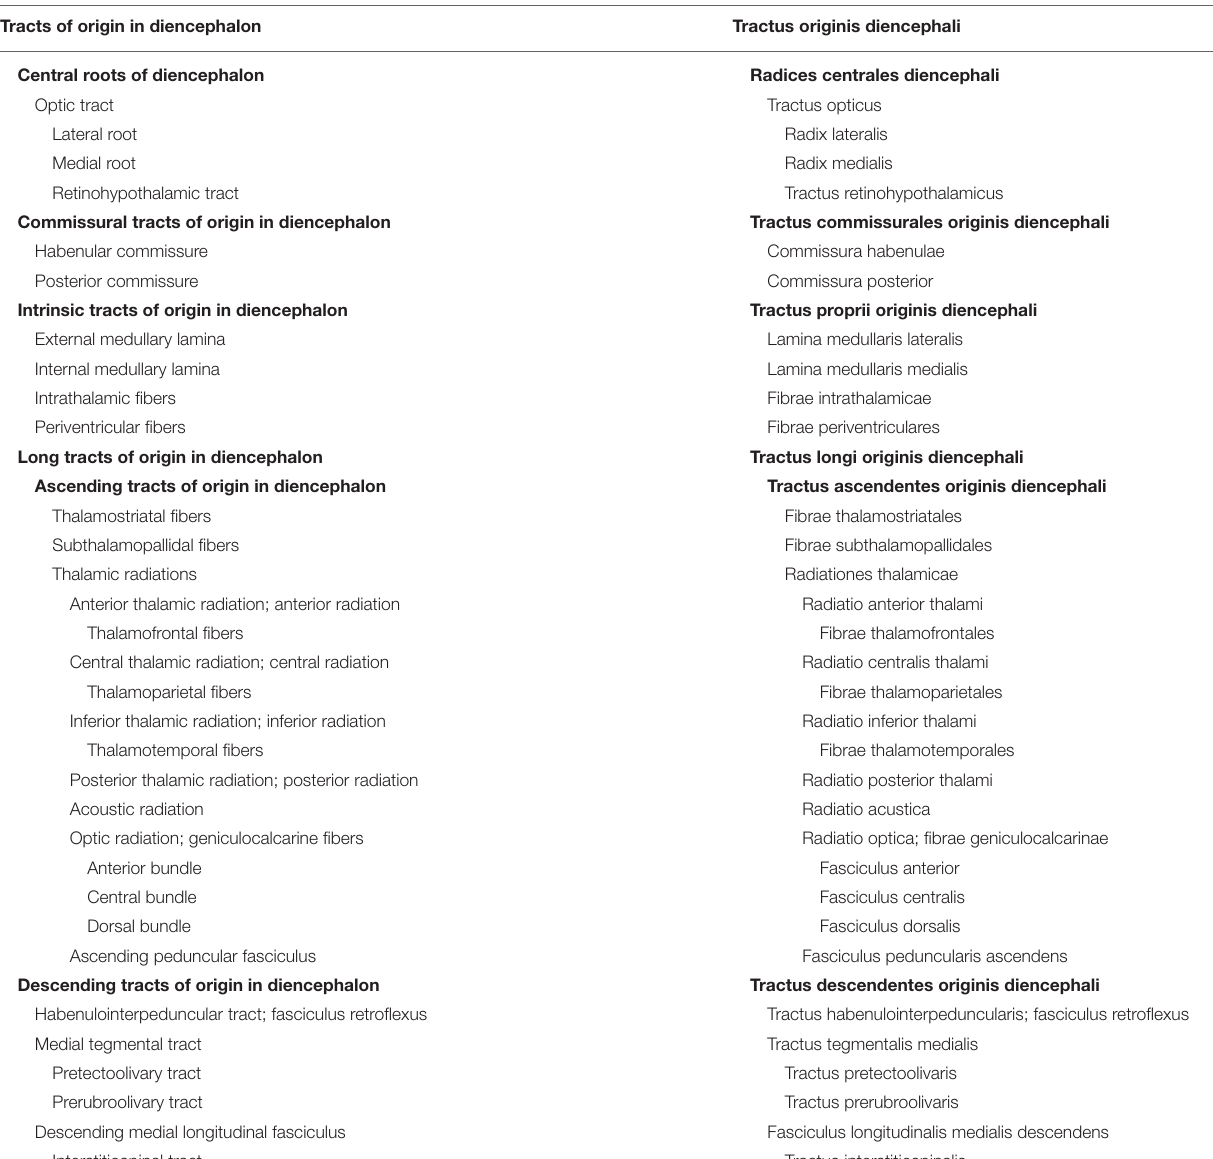
TABLE 3 | Tracts of origin in the